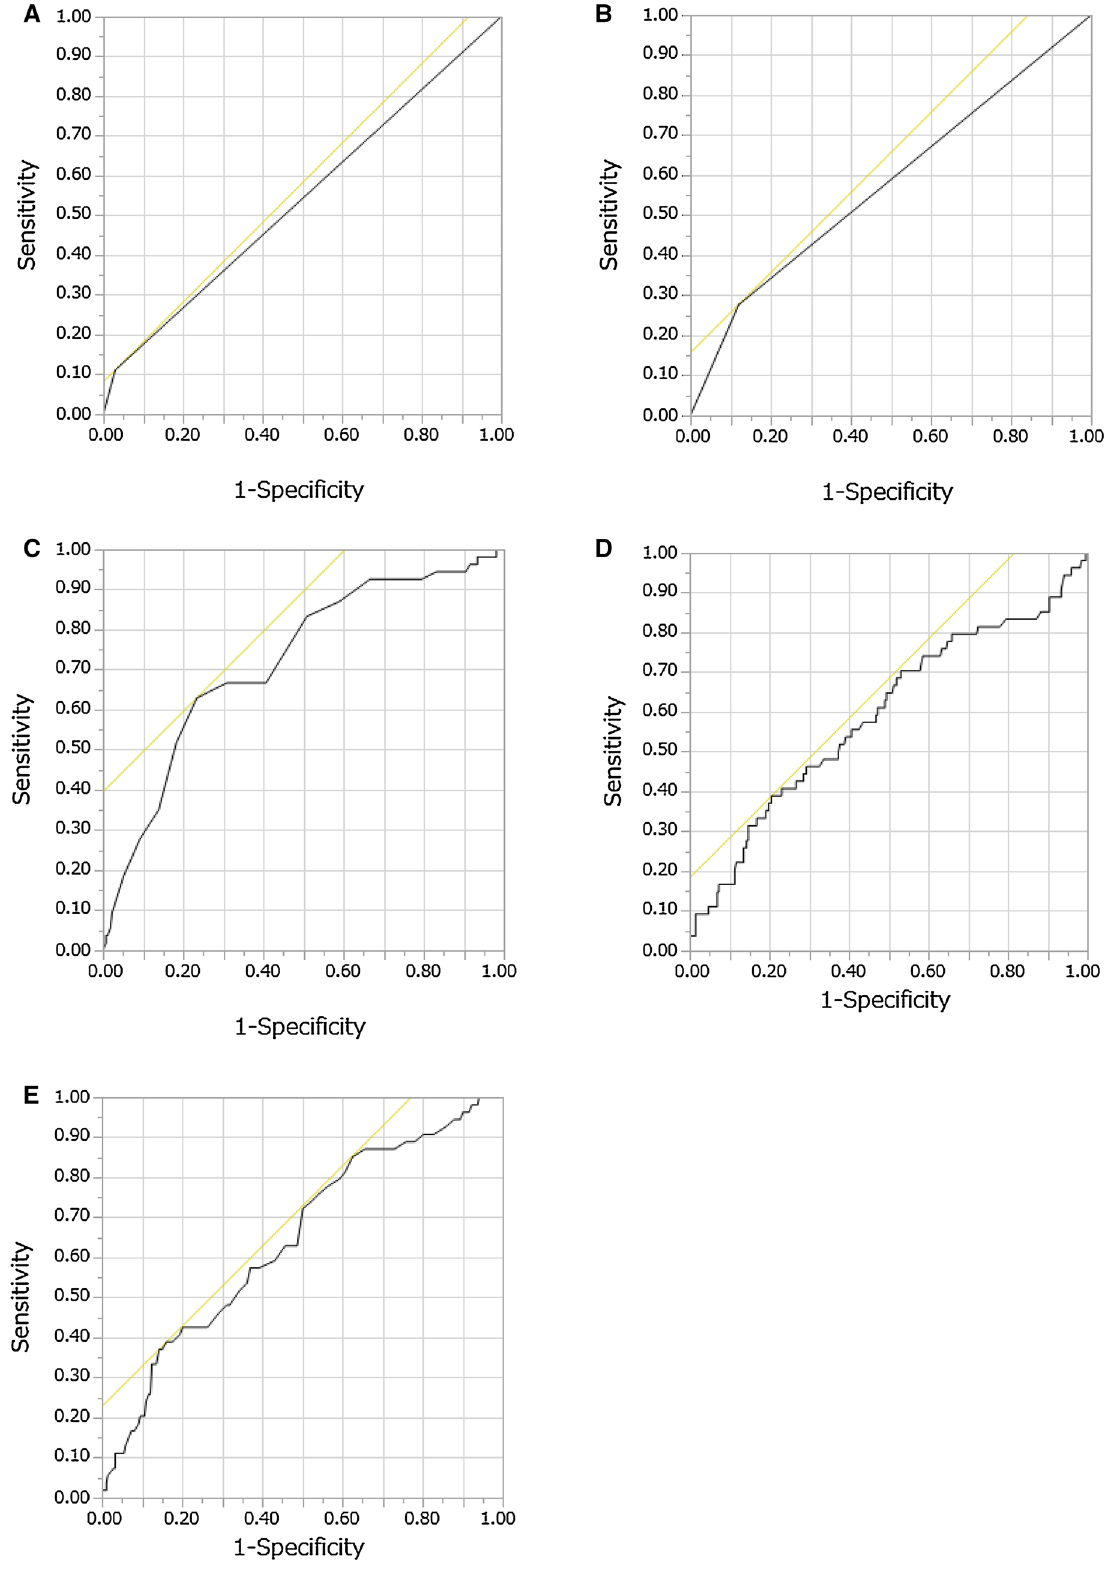
Figure 1. ROC curves about hypocalcaemia (≥ Grade 1) according the logistic regression significant variables. ( A ) ROC curve of concomitant use of vonoprazan with a sensitivity of 11.1% and specificity of 97.1% (AUC = 0.54). ( B ) ROC curve of dexamethasone with a sensitivity of 27.8% and specificity of 87.9% (AUC = 0.58). ( C ) ROC curve of the pre-treatment levels of serum calcium with a sensitivity of 63.0% and specificity of 76.6% (AUC = 0.72). ( D ) ROC curve of alkaline phosphatase with a sensitivity of 38.9% and specificity of 79.5% (AUC = 0.59). ( E ) ROC curve of haemoglobin with a sensitivity of 38.9% and specificity of 83.4% (AUC =